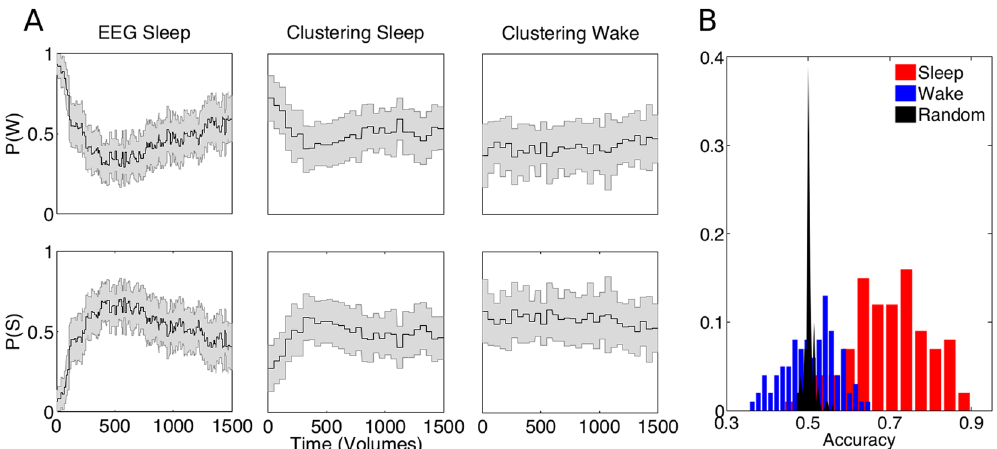
Figure 3. Validation using the wake only and the sleep data sets. ( A ) Probabilities of observing wakefulness ( P ( W )) and any NREM sleep stage ( P ( S )) in the data set containing sleep (“sleep data set”) based on the EEG scoring (left column, “EEG sleep”) and the matched clustered dynamic connectivity states (middle column, “Clustering sleep”) and respective probabilities for the clustered dynamic connectivity states in the wake only data set (right column, “Clustering wake”). For the latter data set, probabilities for the EEG-based scoring are not shown ( P ( W ) equaling 1 and P ( S ) equaling zero by definition). All plots are mean ± SEM. ( B ) Distribution of accuracies obtained using a bootstrapping procedure with 10 randomly selected participants and 100 iterations, shown for the data set containing sleep epochs (red, “Sleep”), the wake only data set (blue, “Wake”) and the sleep data set with randomized sleep stage labels (black,